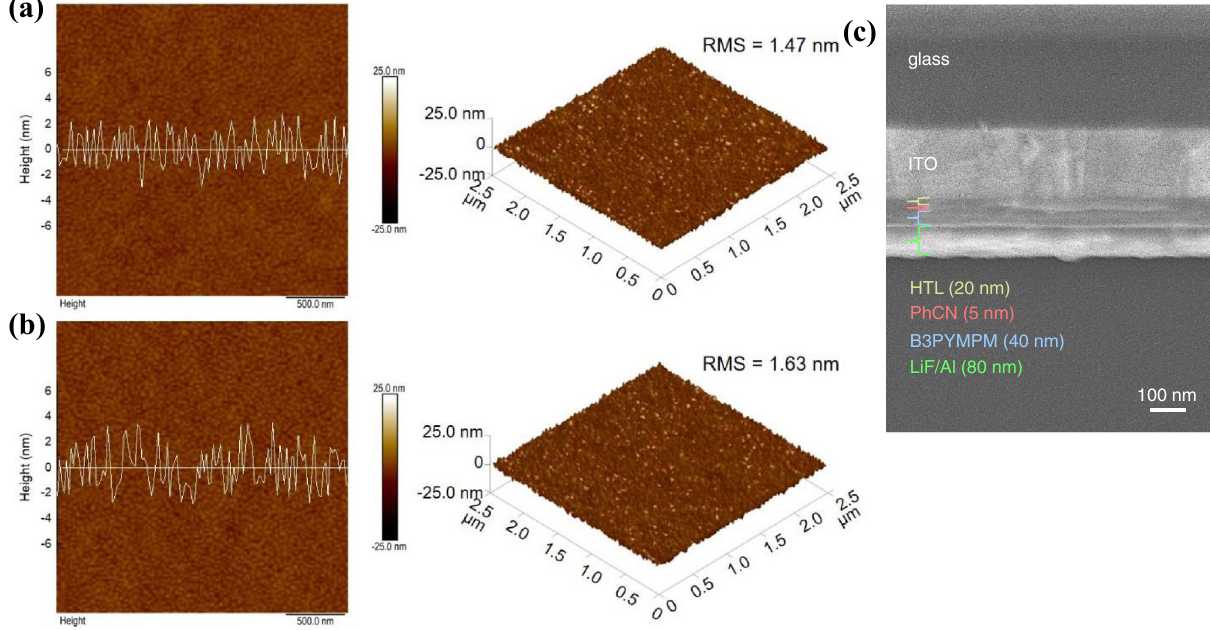
Fig. 7 | Morphology ofPhCN fi lmsand device. AFM images ofPhCN fi lmsdepositedon a PEDOT:PSS/PVK and b PEDOT:PSS/TFB/PVKsurfaces, including height images (left), corresponding line-scan pro fi le images and pseudo-three-dimensional images (right). c Cross-sectional SEM image of device III.